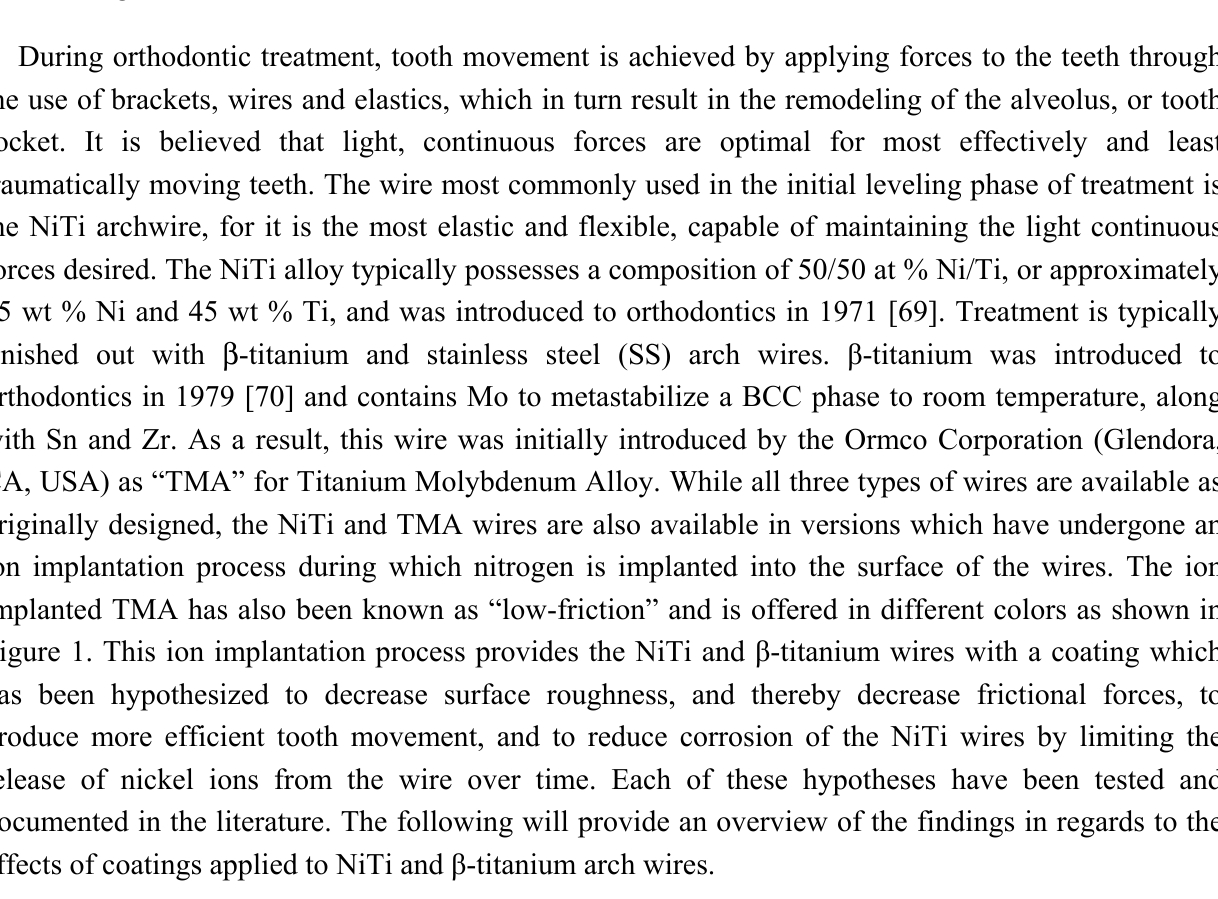
Figure 1. Ion implanted β -titanium orthodontic archwires (honeydew and